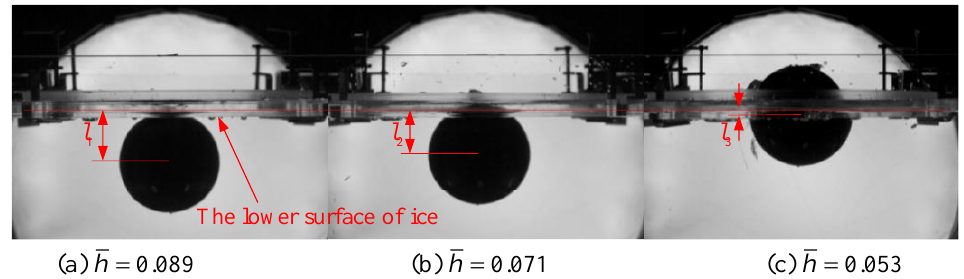
Figure 12. Equilibrium positions of the sphere after colliding with the ice plate at different h , as denoted in the subfigures, with ρ = 0.6 and L 0 = 2.31.